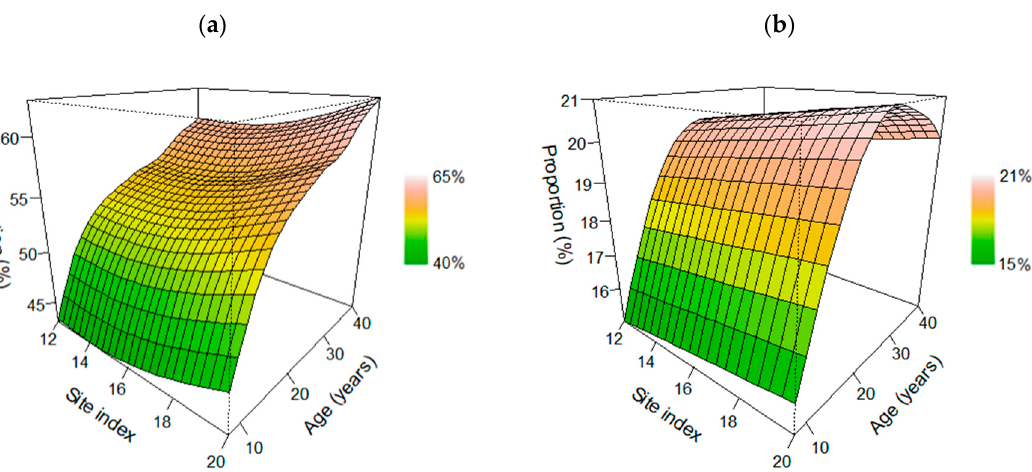
Figure 5. Observed proportion of biomass of stems and roots with site index and time interactions by GAMM. ( a ) Represents stems, ( b ) represents roots.